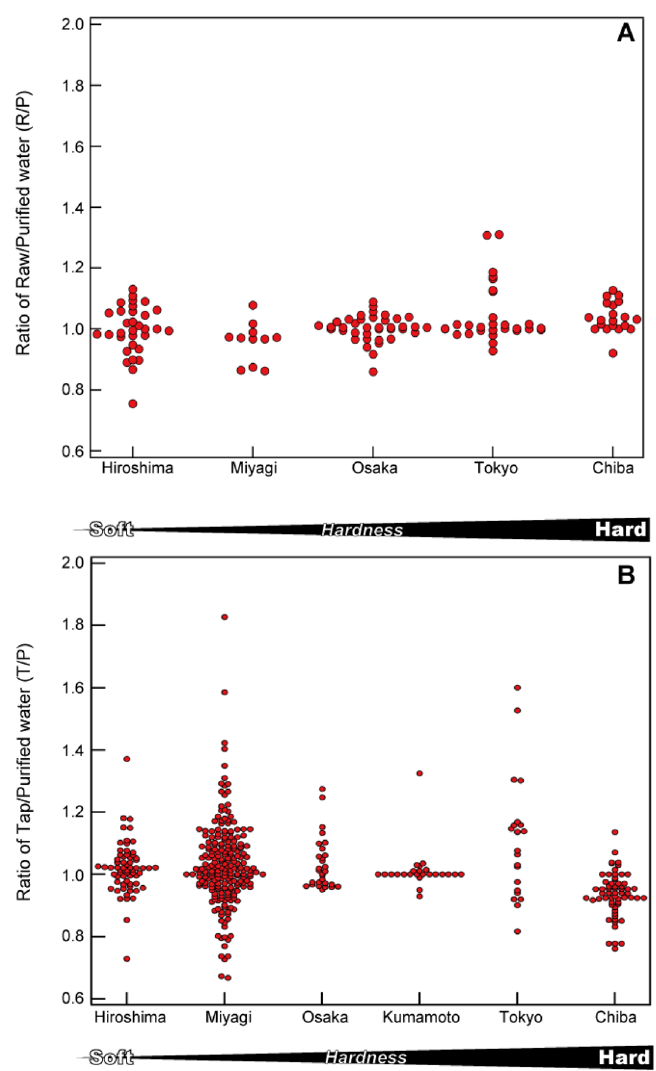
Figure 7. Distribution of R/P and T/P ratios in Hiroshima and Miyagi (relatively soft water), in Osaka (water with average hardness), and in Tokyo and Chiba (relatively hard water). For Kumamoto prefecture, only purified water and tap water data were available. ( A ) Represents R/P ratio; ( B ) represents T/P ratio. These data were calculated from municipal reports 54–60 and our